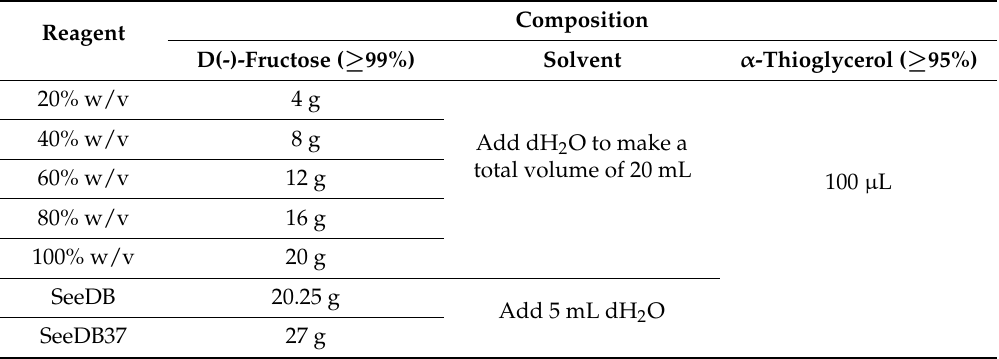
Table 1. List of reagents and corresponding composition of reagents used in the clearing procedure of the OC